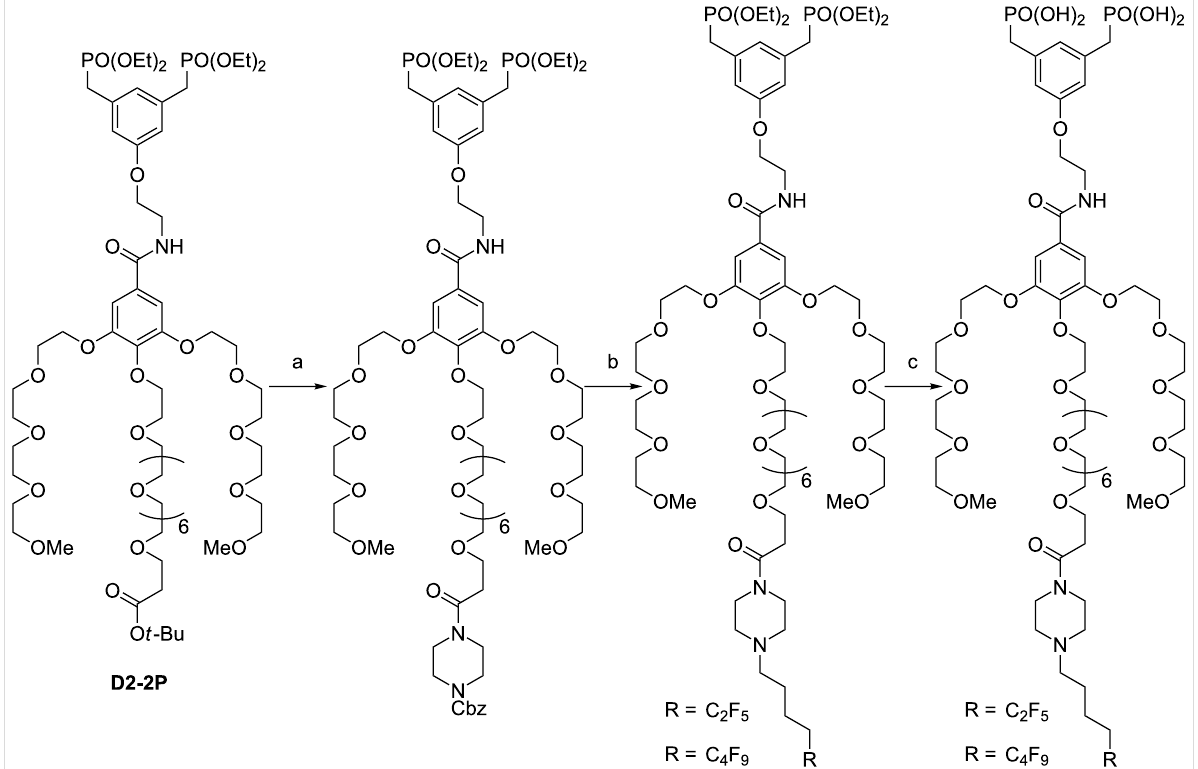
Scheme 1: Final steps of the synthesis of the dendrons C 2 F 5 OEG 8 Den and C 4 F 9 OEG 8 Den. a) TFA/CH 2 Cl 2 , then piperazine-NCBz, HATU, DIPEA/ DMF; 99% (2 steps); b) H 2 , Pd/C/ MeOH, then perfluoroalkyl iodide, K 2 CO 3 /CH 3 CN; 80% for C 2 F 5 and 55% for C 4 F 9 ; c) TMSBr/CH 2 Cl 2 ; 79% for C 2 F 5 and 80% for C 4 F 9